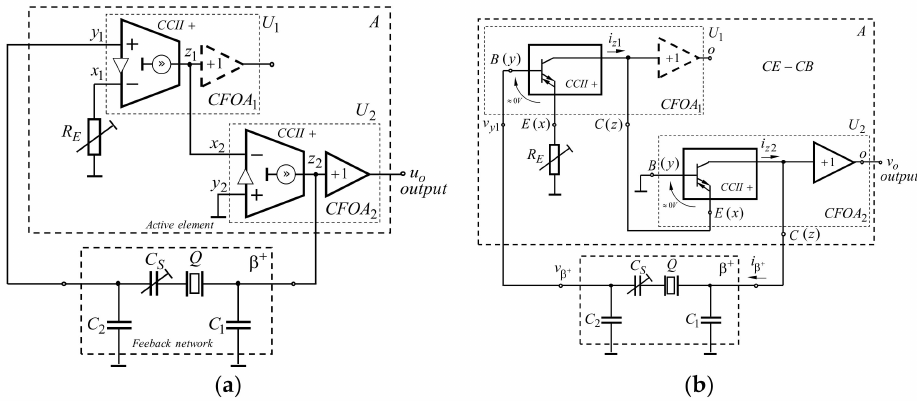
Figure 3. Two-stage oscillator using quartz-crystal resonator which is behaving as an inductor (or equivalent two-stage Pierce oscillator employing four-terminal CFOAs) (QO1): ( a ) circuit diagram with two CCIIs, represented as parts of four-terminal CFOAs; ( b ) circuit diagram with two CCIIs, represented as a cascode (common emitter–common base)